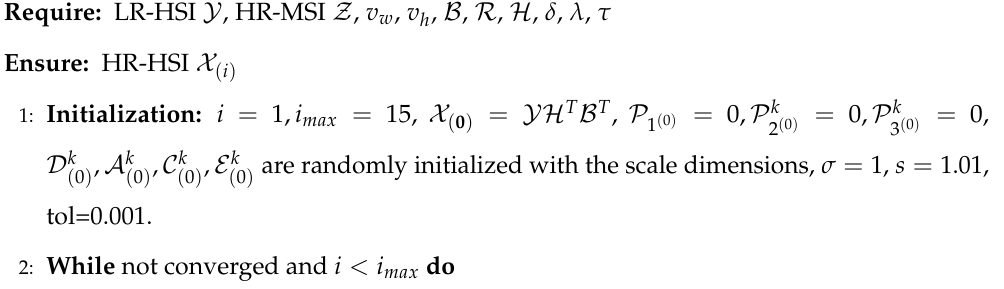
Algorithm 1 The proposed SSTSR method for HSI